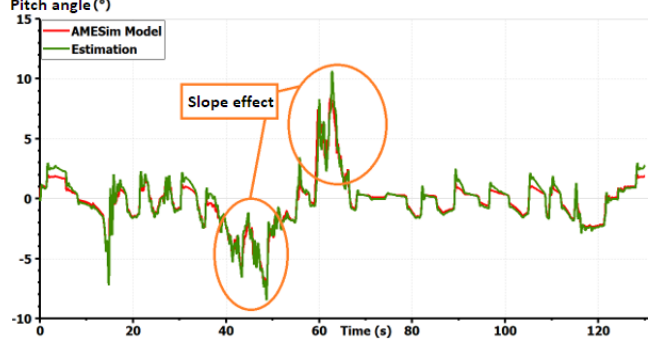
Figure 10. Validation of the vehicle model: pitch angle taking into account the slopes